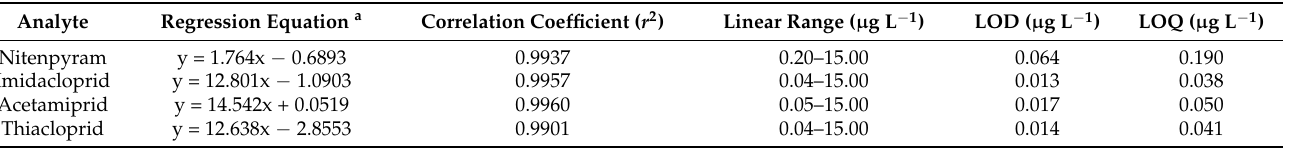
Table 1. Regression equation, linear range, correlation coefficient ( r 2 ) and method detection limit, and limit of quantification of four neonicotinoid insecticides.